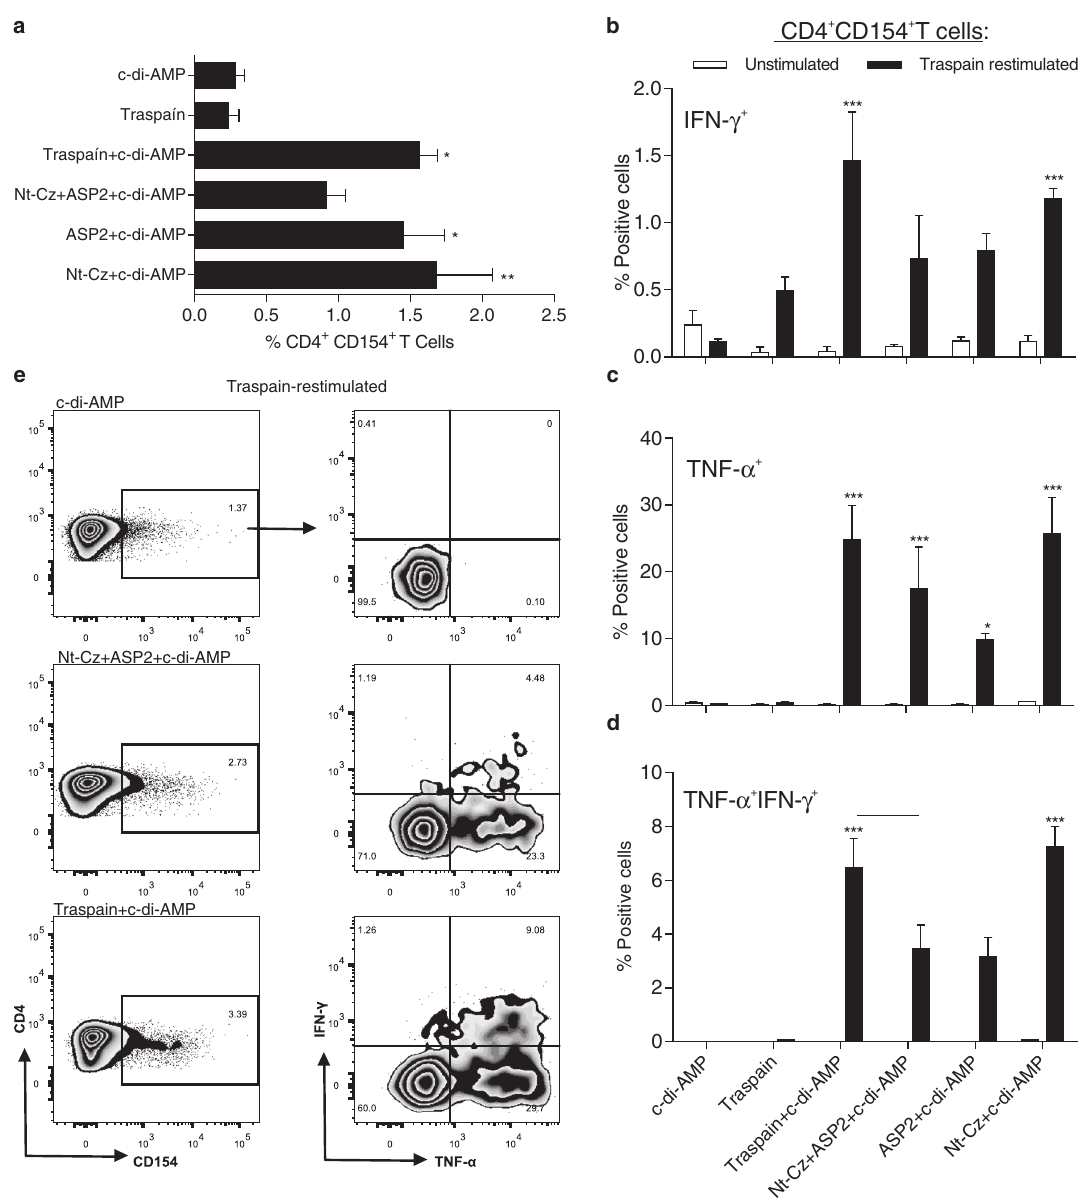
Fig. 3 Antigen-speci fi c CD4 + T cells generated during vaccination become activated and secrete cytokines upon re-encounter with the cognate antigen. Spleen cells from individual mice were harvested 30 days after last dose and transient expression of CD154 + (CD40L) was analyzed as an indicator of T cell activation upon antigen recall ( a ). Results are expressed as subtracted mean(restimulated mean — unstimulated mean) ± SEM. TNF- α and IFN- γ production by activated CD154 + CD4 + T cells. Percentage of cytokine producing cells was determined for IFN- γ + ( b ), TNF- α + ( c ), or TNF- α + IFN- γ + cells ( d ). Flow cytometry plots for the indicated groups showing the gating strategy ( e ). * p < 0.05, ** p < 0.01, *** p < 0.001 comparing with c-di-AMP. One-way-ANOVA + Bonferroni multiple comparisons test ( a ) and two-way-ANOVA + Bonferroni multiple comparisons test ( b – d ), bar indicate p < 0.05 between groups, n = 4 per group. All results are representative of two independent